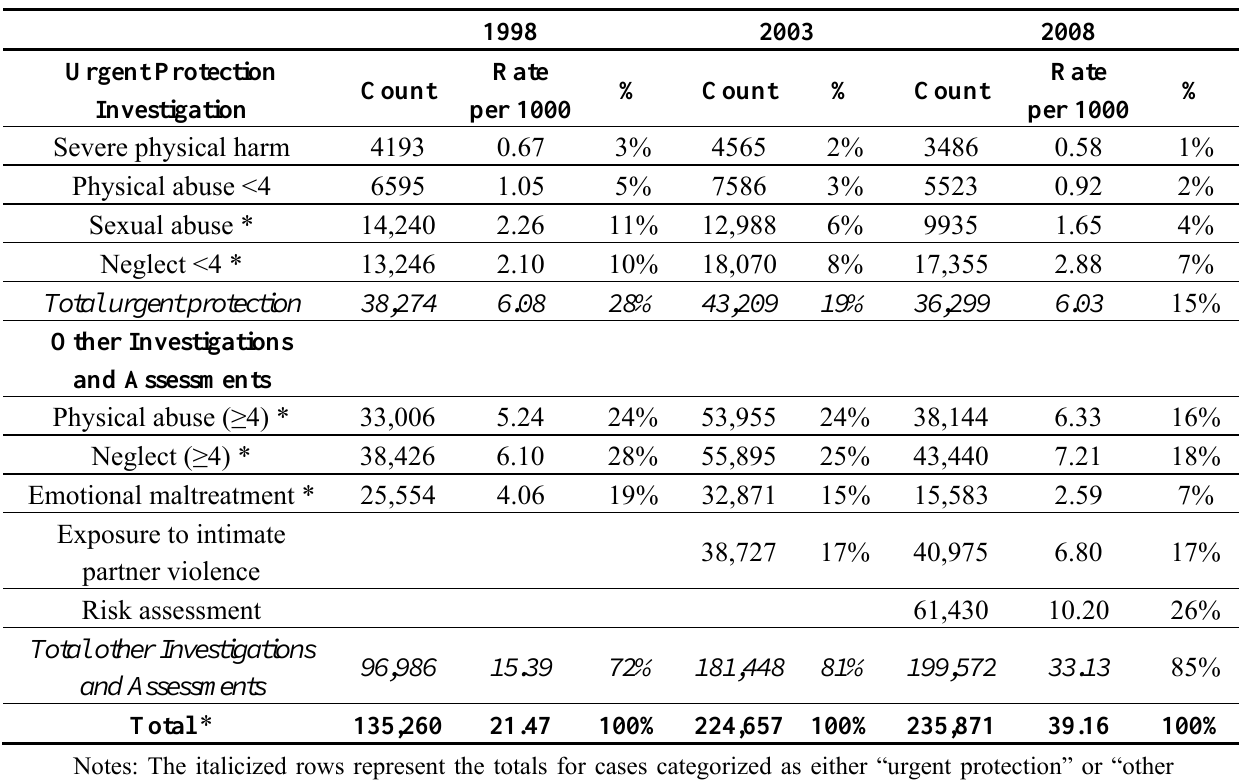
Table 2. Types of child welfare investigations and assessments conducted in Canada, Canadian Incidence Study of Reported Child Abuse and Neglect (CIS) 1998, 2003 and